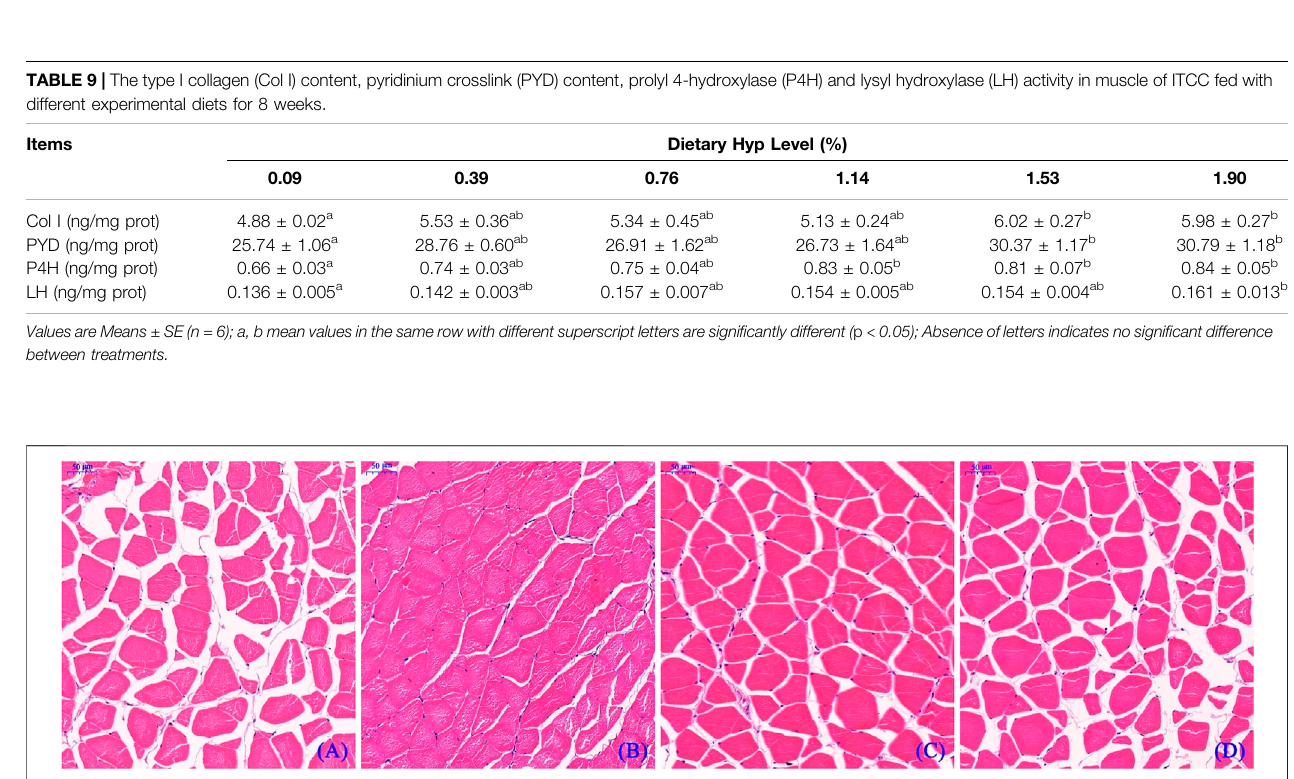
TABLE 10 | The muscle fi ber diameter (DI) and density (DE) of ITCC fed with different experimental diets for 8 weeks.